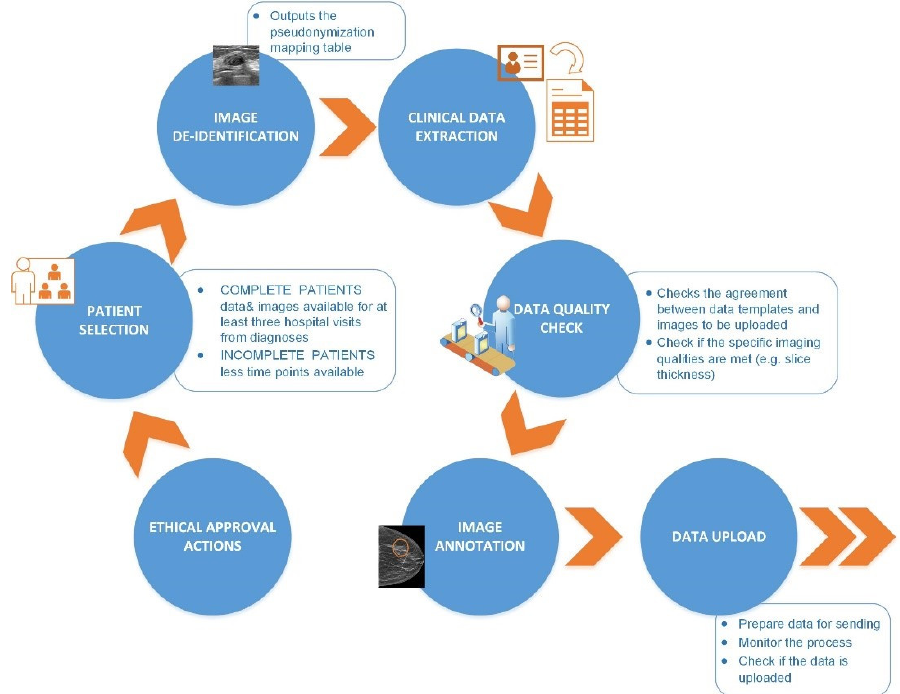
Figure 6. INCISIVE data collection process. Table 1. The modality annotation convention in the INCISIVE project.